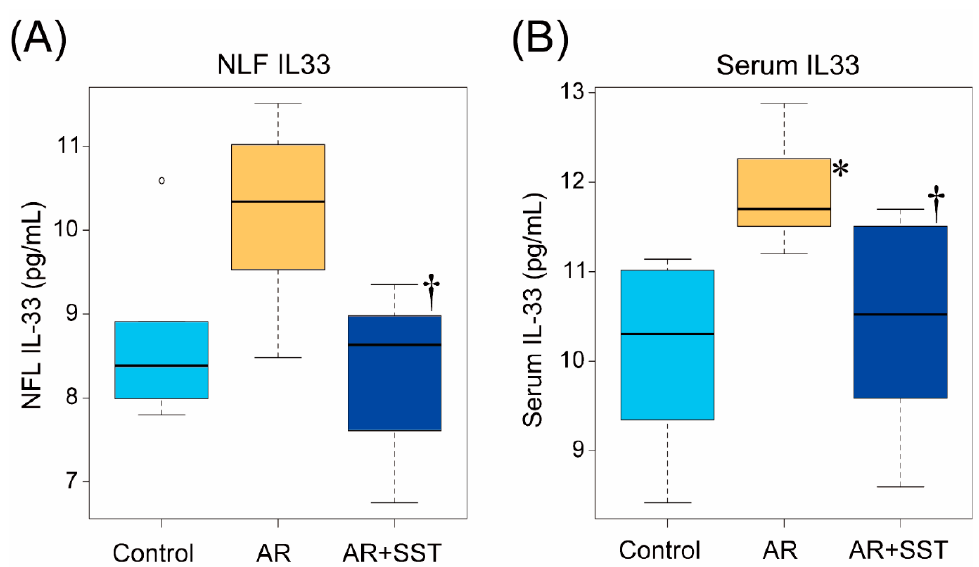
Figure 3. SST inhibited the increase of IL-33 concentrations in NLF and serum. ( A ) IL-33 concentra- tion in NLF. (n = 6) † p < 0.05 vs. AR group. (One-way ANOVA followed by Tukey’s multiple comparisons). ( B ) IL-33 concentration in serum. Values are the mean ± SEM. (n = 6) * p < 0.05 Control group; † p < 0.05 vs. AR group (One-way ANOVA followed by Tukey’s multiple comparisons).